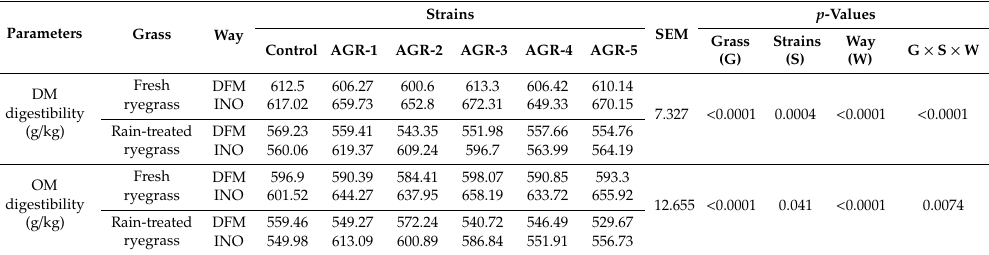
Table 7. E ff ect of LAB strains on dry matter and organic matter